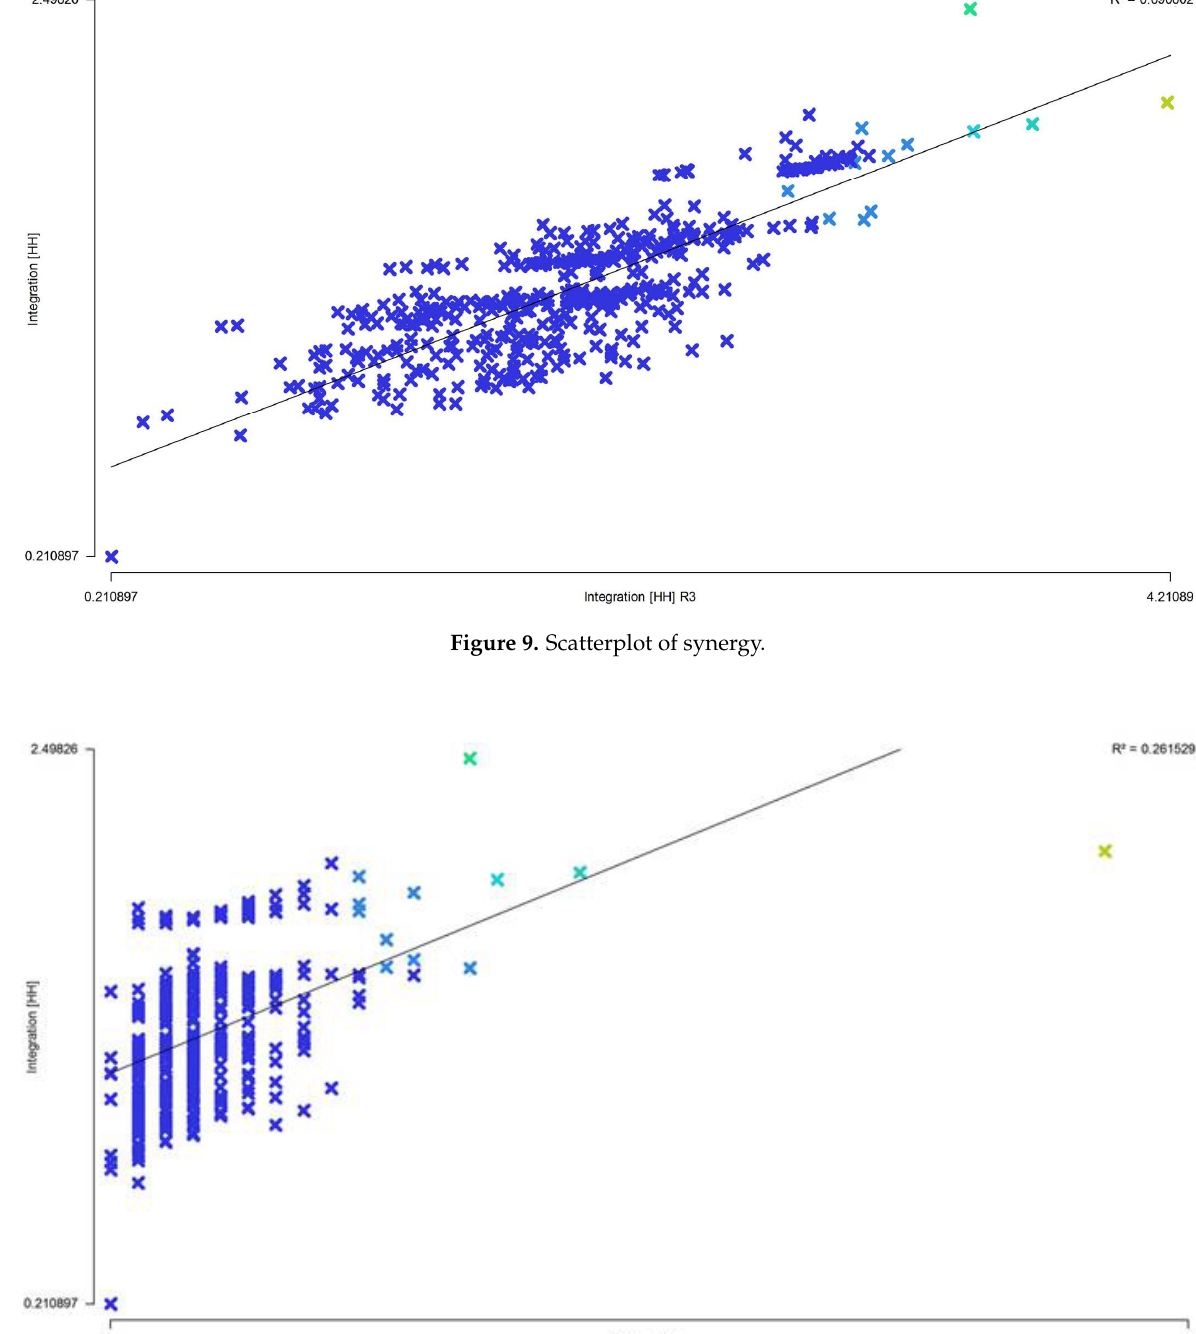
Figure 10. Scatterplot of